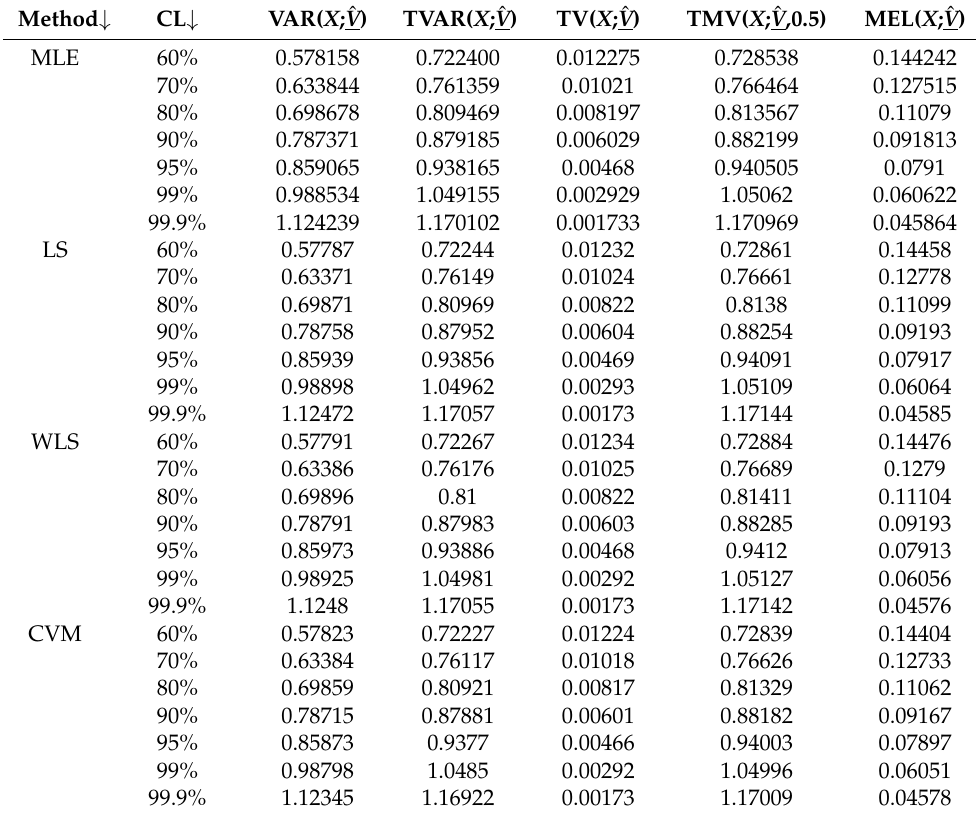
Table A2. The KRIs for the GRC under artificial data where n =